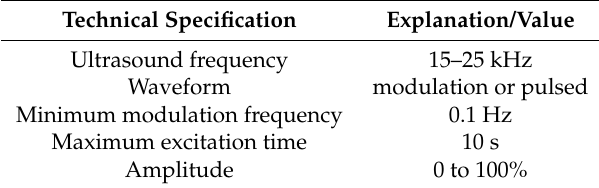
Table 3. The ultrasound excitation sepup technical